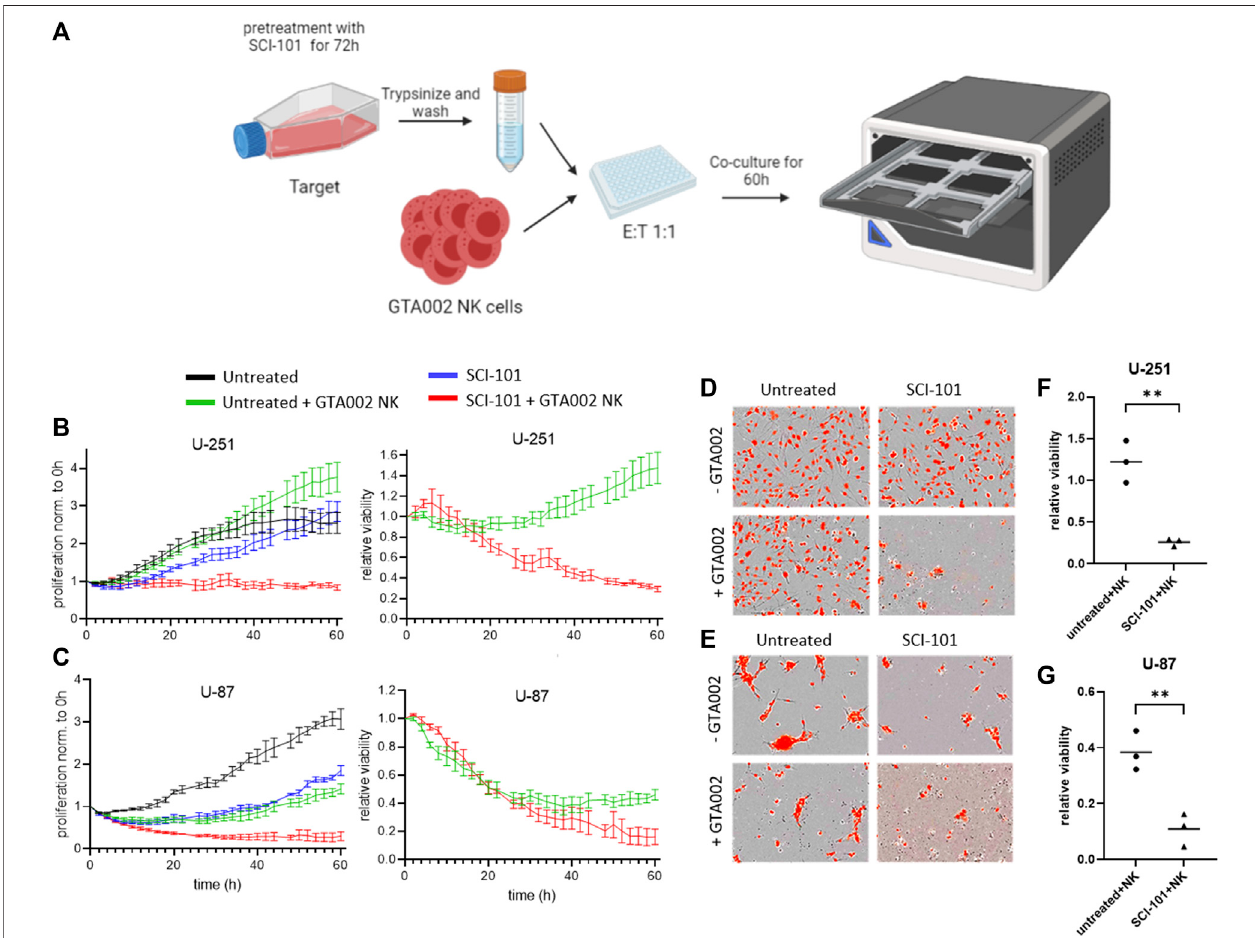
FIGURE 6 | SCI-101 treatment augments glioblastoma susceptibility to GTA002-mediated killing. (A) U-87 or U-251 cells pre-treated for 72 h with 5 μ M SCI-101 or left untreated were co-cultured with GTA002 cells at an E:T ratio of 1:1 for 60 h in Incucyte. (B, C) Cell proliferation traces normalized to time point 0 h and to the relativeviabilityofU-251 (B) andU-287 (C) areshownasthemean ± SEMoftechnicalquadruplicatesforoneGTA002donor. (D,E) RepresentativeimagesofU-251 (D) and U-287 (E) at t (cid:2) 60 h. Tumor cells are shown with red nuclei. (F, G) Statistical analysis of relative viability was performed using the nested t-test at t (cid:2) 60 h for U- 251 (F, p (cid:2) 0.0029) and U-287 (G, p (cid:2) 0.0078). Data are shown as the mean ± SEM of n (cid:2) 3 GTA002 donors with ** p < 0.01.